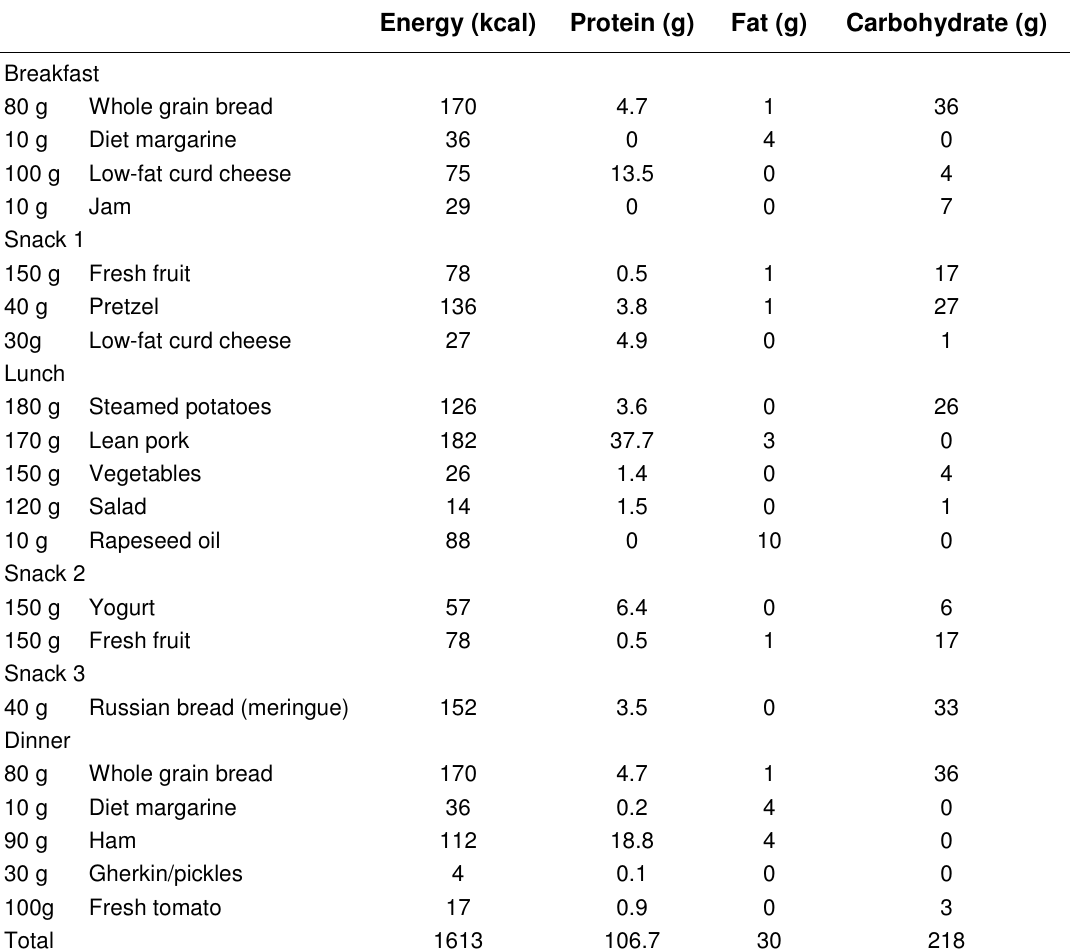
Dietary Example for PWS (1600